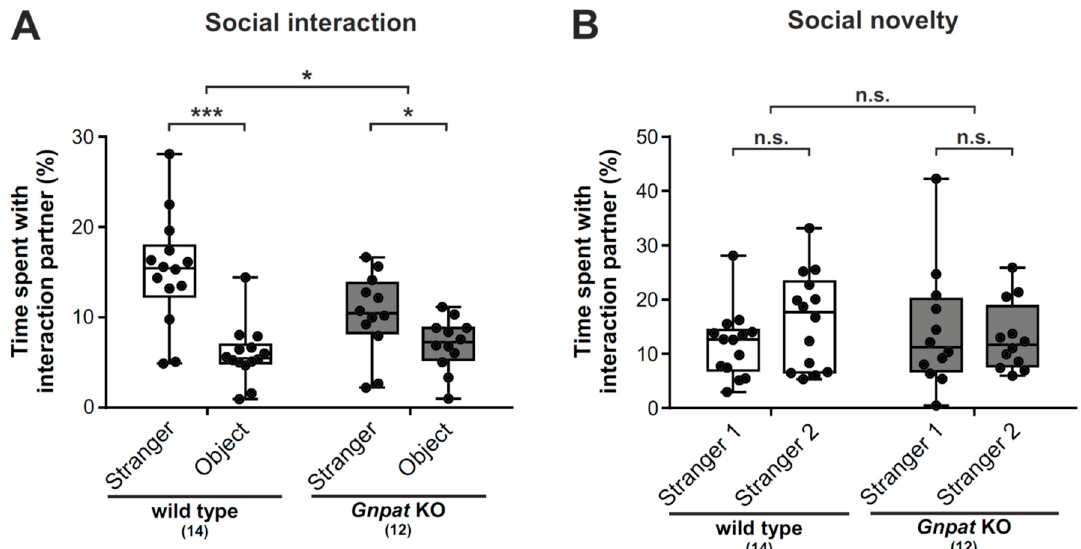
Figure 1. Gnpat knockout (KO) mice show deficient social interaction but no apparent changes in the response to social novelty: A three-chamber approach was used to assess sociability ( A ) and the response to social novelty ( B ). In the social interaction task, the time spent interacting with an unfamiliar mouse (“stranger”) or a neutral, novel object (“object”) was quantified automatically. For the evaluation of social novelty, mice were exposed to a previously encountered mouse (“stranger 1”) in one chamber and a completely unfamiliar mouse (“stranger 2”) in the opposite chamber. The time spent with each of the strangers was quantified automatically. Data are shown as box plots together with individual data points, and whiskers indicate minimal and maximal values. The number of tested animals is given in brackets. Statistical analysis was performed using paired, two-tailed Student’s t -tests (for the comparison of the preferences within each genotype) and repeated measures two-way ANOVA (for comparison of the genotypes). The findings displayed in Figure 1A have been published previously in a smaller cohort of wildtype (WT) and Gnpat KO mice [11]. *** p < 0.001, * p < 0.05; n.s. , not significant .